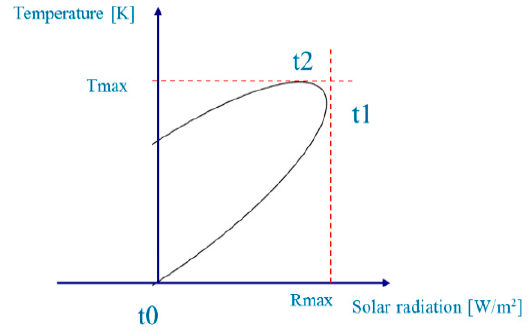
Figure 4. The relationship between the land surface temperature and net surface shortwave radiation.